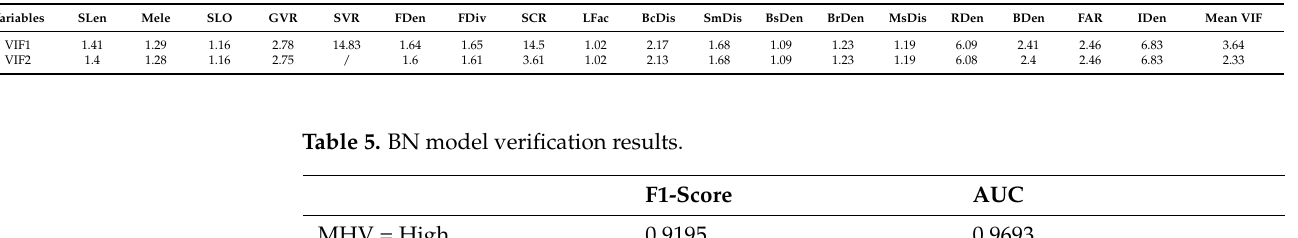
Table 4. Results of two multicollinearity tests.